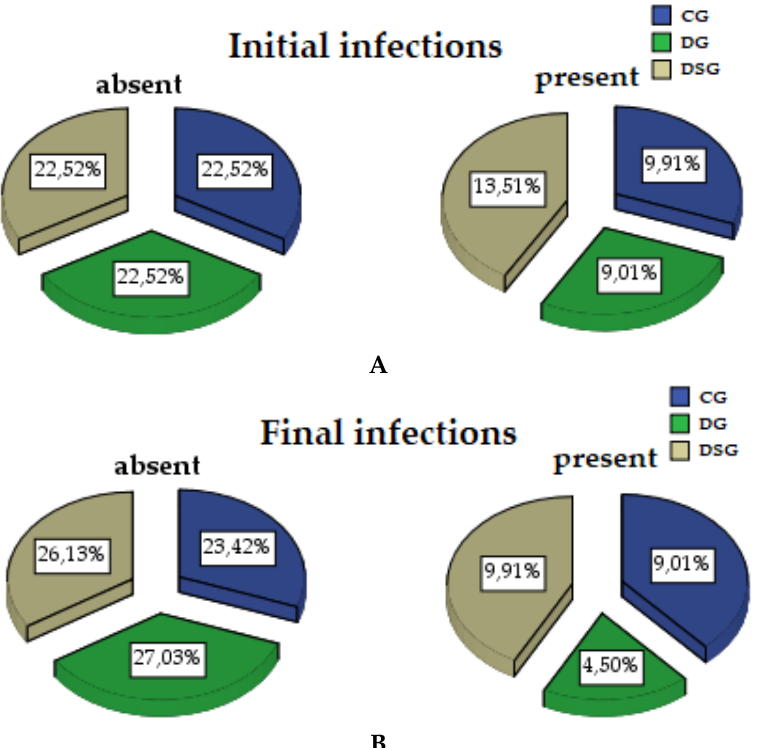
Figure 3. The evolution of the infection of the gum to the three research groups com-sounding initial infection ( A ) with the final ( B ).